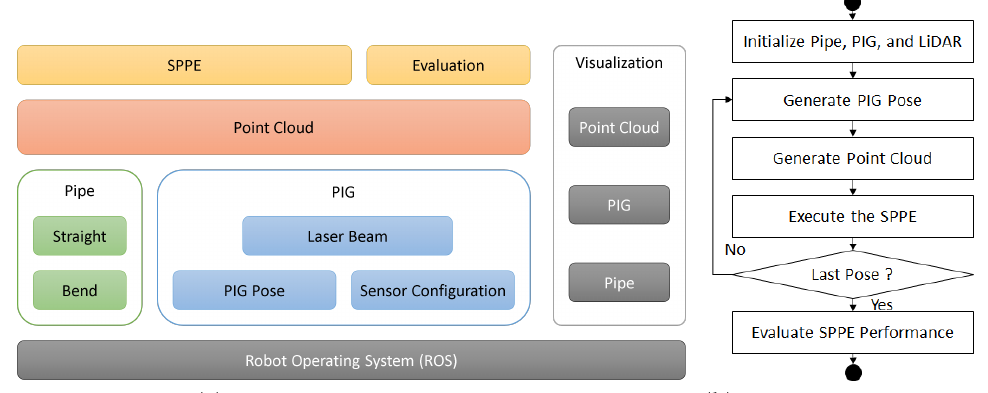
Figure 7. Our PIG